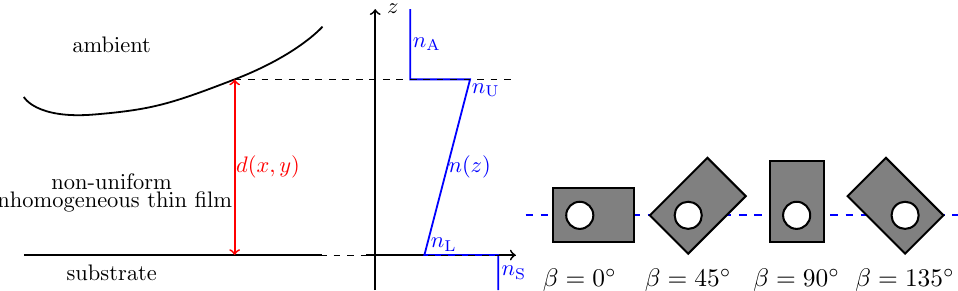
Figure 1. Schematic diagram of the inhomogeneous thin film nonuniform in thickness ( left ). Schematic diagram of the positions of the samples during ellipsometric measurements ( right ), the dashed line represents the intersection of the plane of incidence with the sample